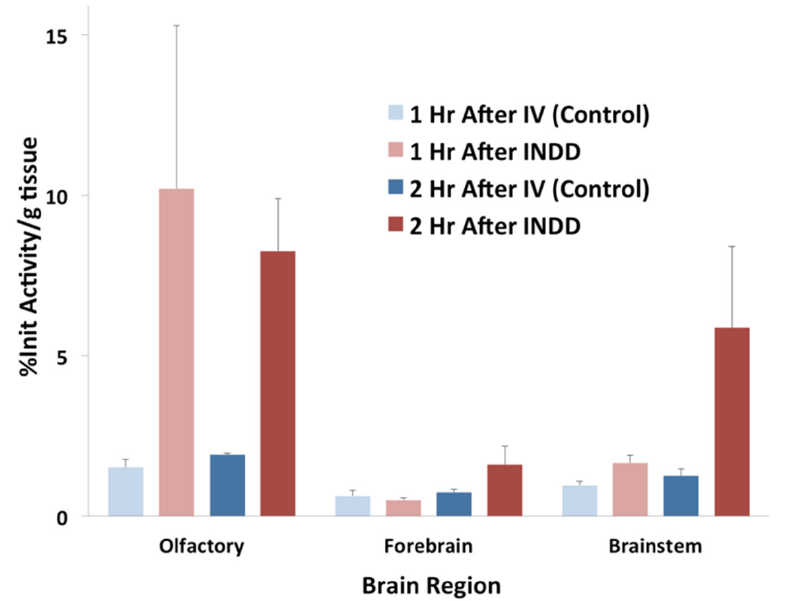
Figure 8. Quantitative brain region activity at 1 and 2 h following INDD of 100 nm PLA–PEG– 89 Zr NPs, as detected by gamma counting ex vivo. The percentage of initial activity per gram of tissue was calculated using a standard gamma counter to determine the differential activity in various regions throughout the brain. Similar to the PET/CT data, the signal activity was highest in the olfactory region and brainstem following INDD of the 100 nm PLA–PEG– 89 Zr NPs. Relatively less activity was seen in the forebrain.